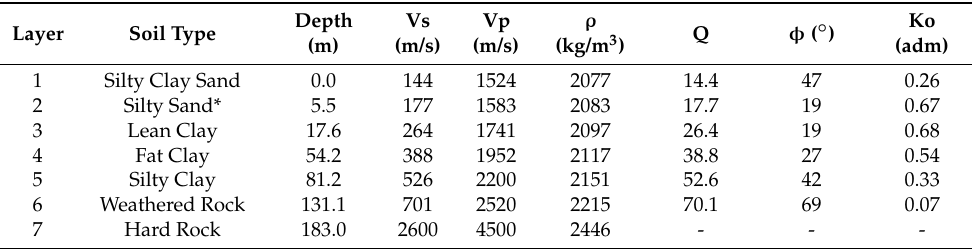
* Water table at 1 m depth. Vs: shear wave velocity. Vp: Compressive wave velocity. ρ : soil density. Q: Anelastic attenuation factor. ϕ : Friction angle. Ko: Coefficient of earth at rest.